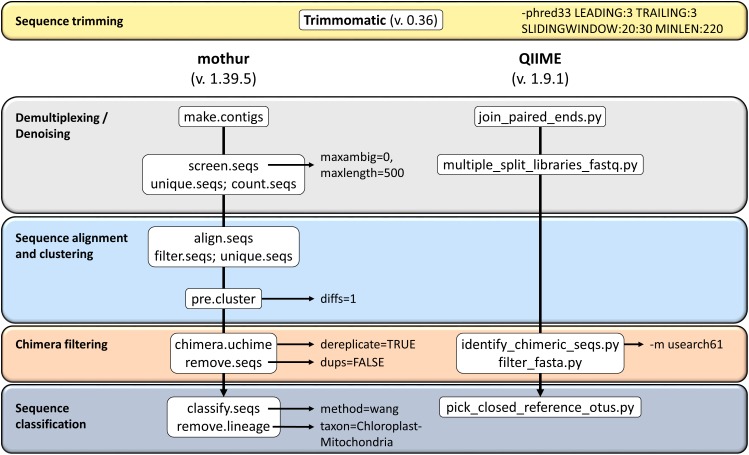
Overview of the workflows used in this study on QIIME and mothur for 16S rRNA amplicons analysis.